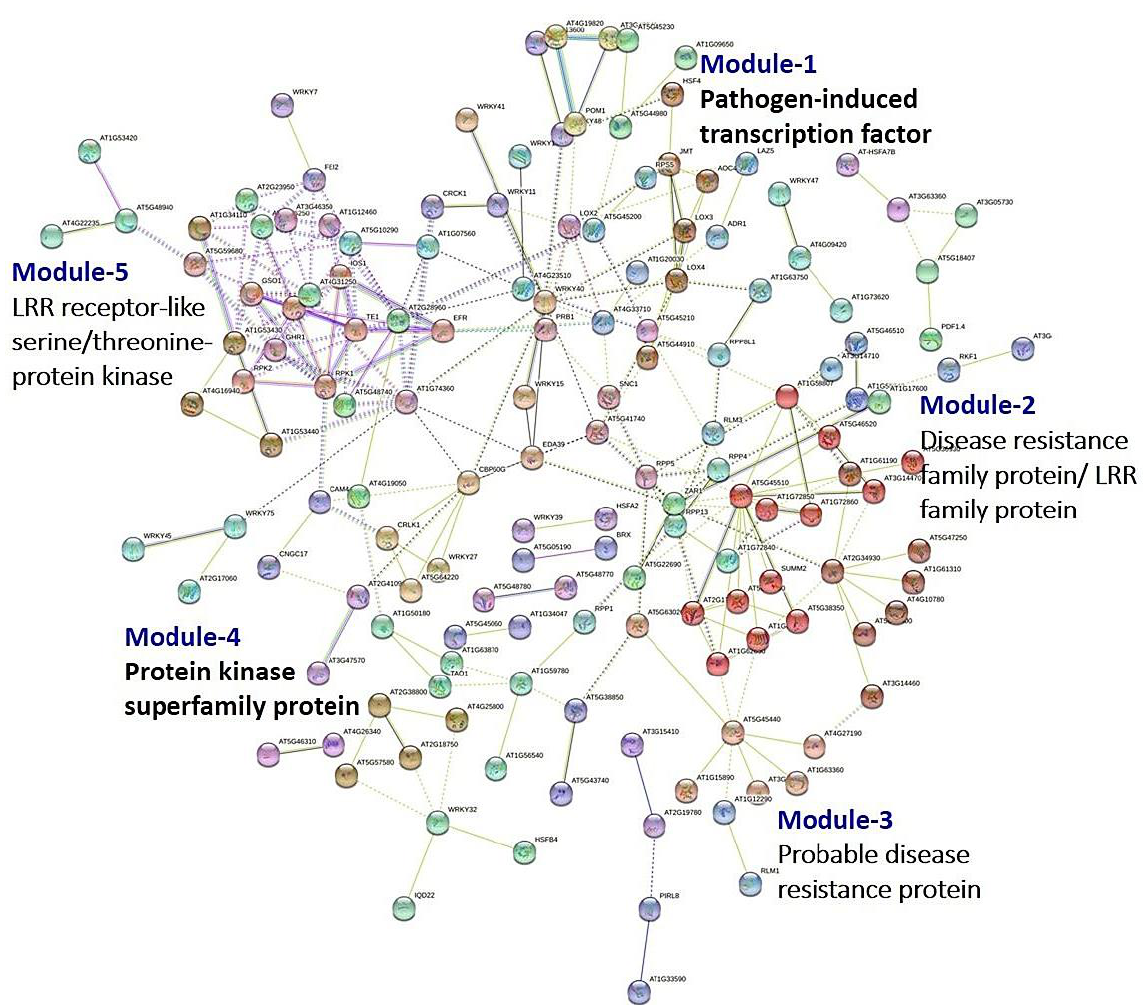
Figure 5. PPI network of lentil genotype Precoz when infected with R. bataticola.